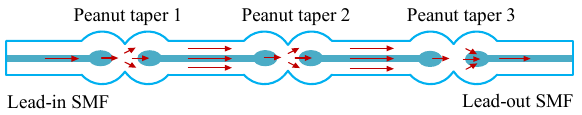
Fig. 1 Structure of the proposed sensor based on cascaded single mode